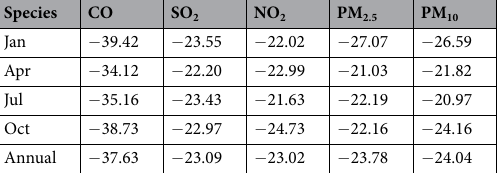
Table 4. Percent contributions of thermal power plant emissions in the BTH region to atmospheric species in Beijing based on assumed total removal of power plants (Case